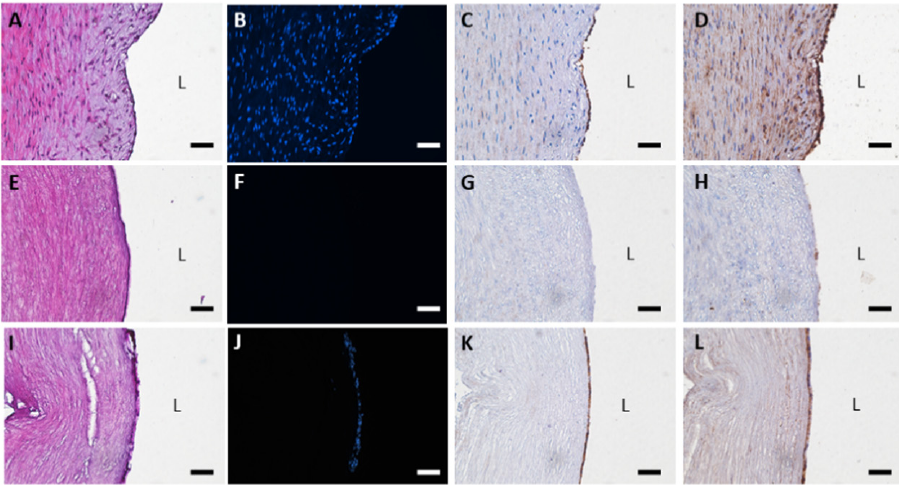
Figure 4. Histological stains of cell seeding sDHUA, 204W for 4 h. ( A – D ) HUA; ( E – H ) sDHUA; ( I – L ) sDHUA seeded with HUVEC; ( A , E , I ) H&E stain; ( B , F , J ) DAPI; ( C , G , K ) CD31; ( D , H , L ) vWF; Magnification: 200 × , Scale bar = 50 µ m. L: lumen.